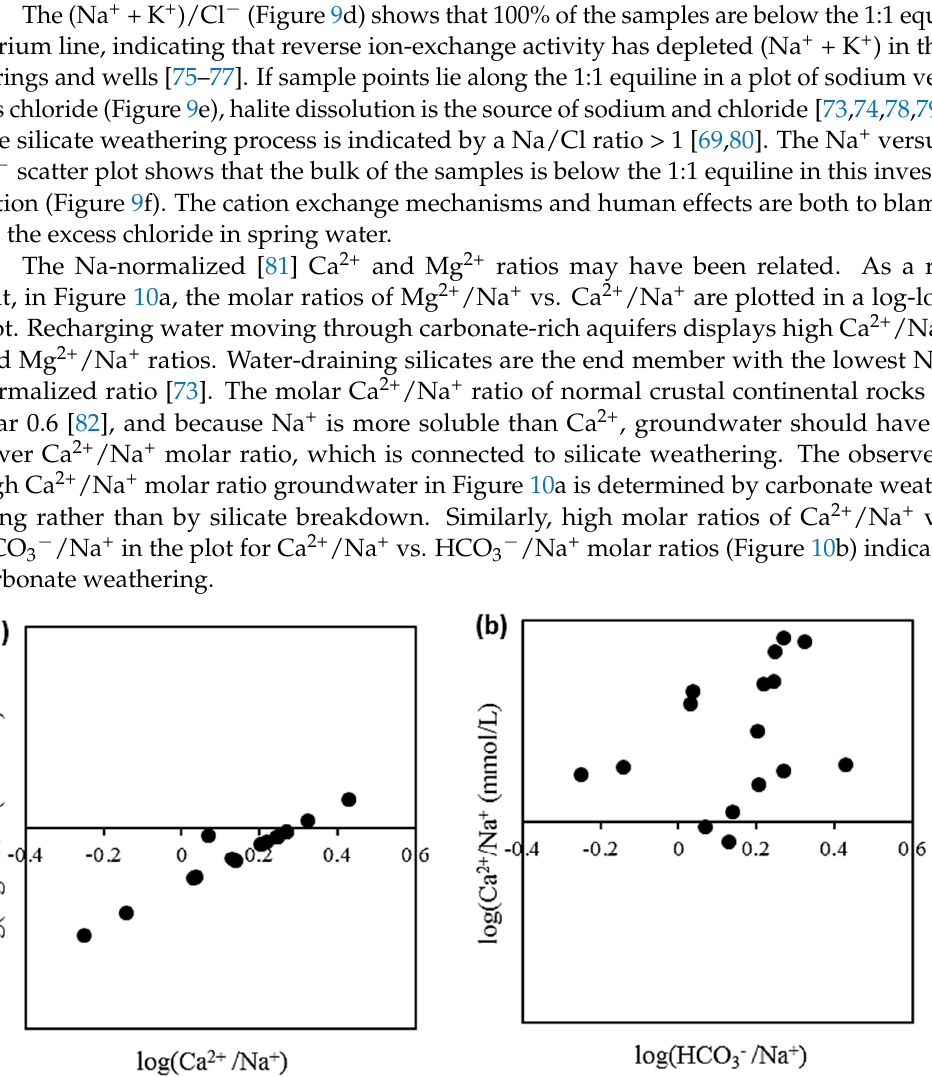
Figure 10. Bivariate plots of ( a ) log (Ca 2+ /Na + ) vs. log (Mg 2+ /Na + ); ( b ) log(HCO 3 − /Na + ) vs. log (Ca 2+ /Na +